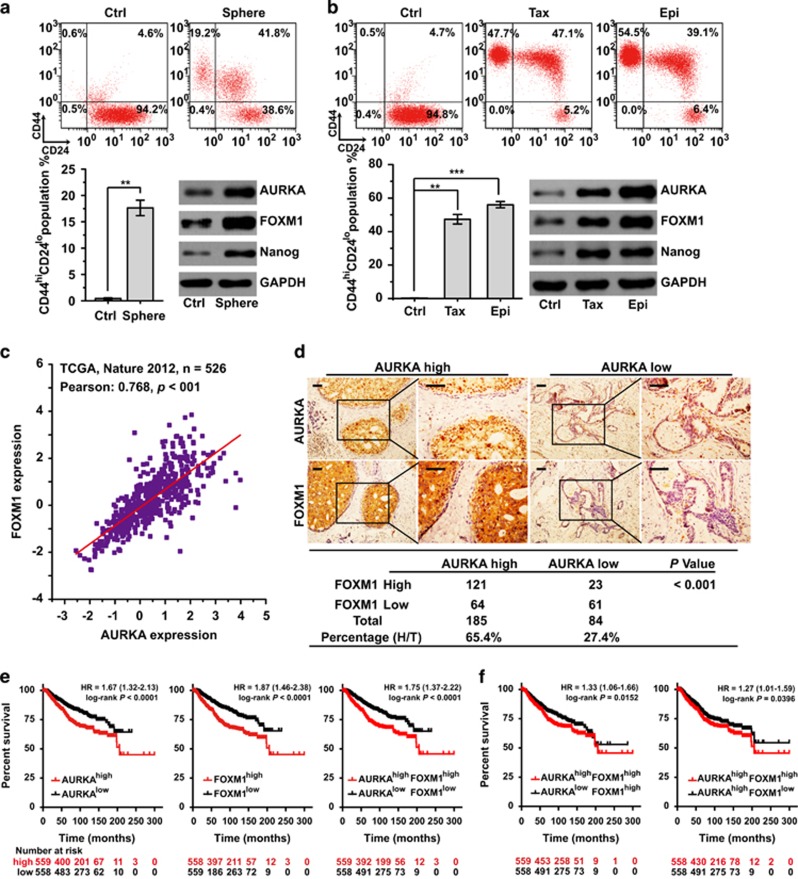
AURKA and FOXM1 co-expression in breast cancer. (a) Flow cytometry and western blot analysis of CD44hi/CD24lo population as well as AURKA and FOXM1 expression in spheroid and control cells. (b) Flow cytometry and western blot analysis of CD44hi/CD24lo population, as well as AURKA and FOXM1 expression in paclitaxel (TaxR) and epirubicin (EpiR) drug-resistant MCF-7 cells. (c) Expression of AURKA and FOXM1 in a TCGA batch consisting of 526 breast cancer patient samples. Pearson's correlation and linear regression analysis were employed. (d) Immunohistochemistry to determine protein expression levels of AURKA and FOXM1 in primary human breast cancer patient samples. Statistical comparisons were made using Chi-square test. (e, f) OS was examined by Kaplan–Meier analysis comparing the indicated subgroups. The above CD44hi/CD24lopopulation assays were repeated at least three times independently and results presented as mean±s.d. **P<0.01; ***P<0.001 significance by Student's t-test (two tailed).